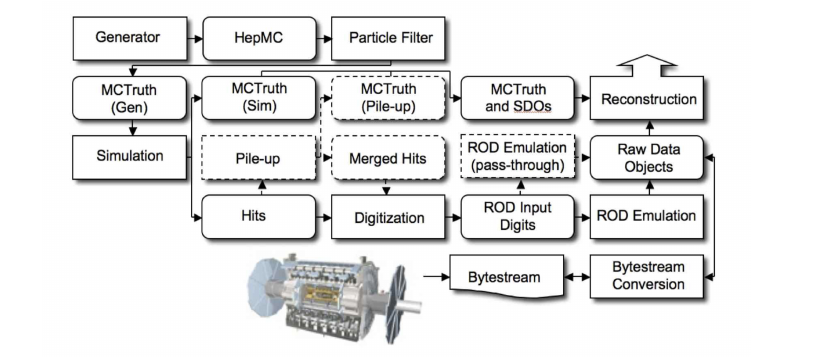
Figure 1: ATLAS Simulation infrastructure flow, from event generators (top left) to recon- struction (top